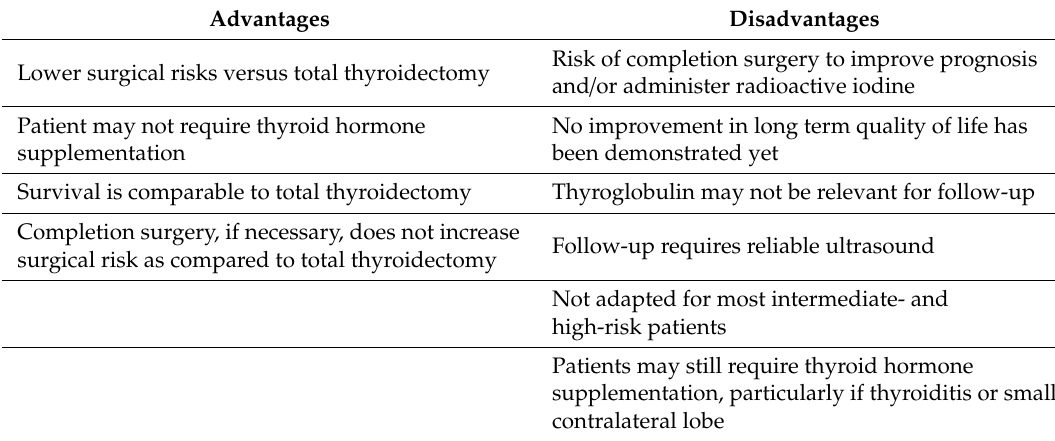
Table 3. Conservative surgery for low to intermediate risk cancers—advantages and